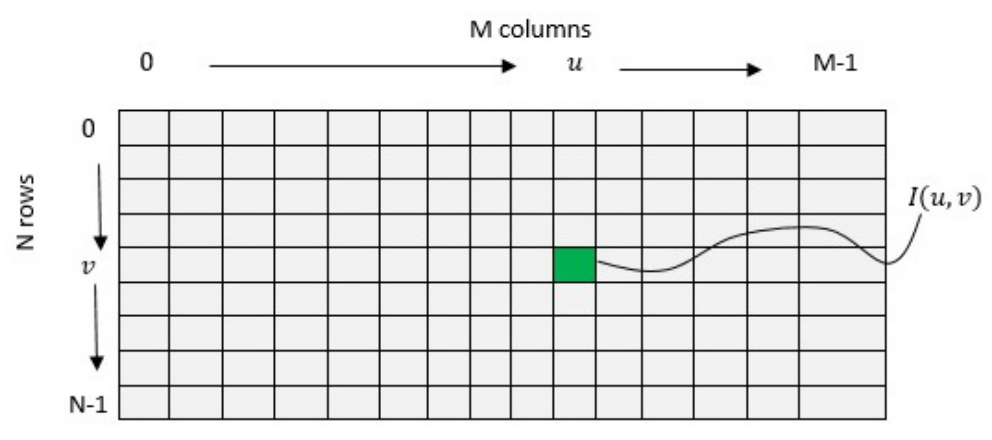
Figure 3. Image coordinates